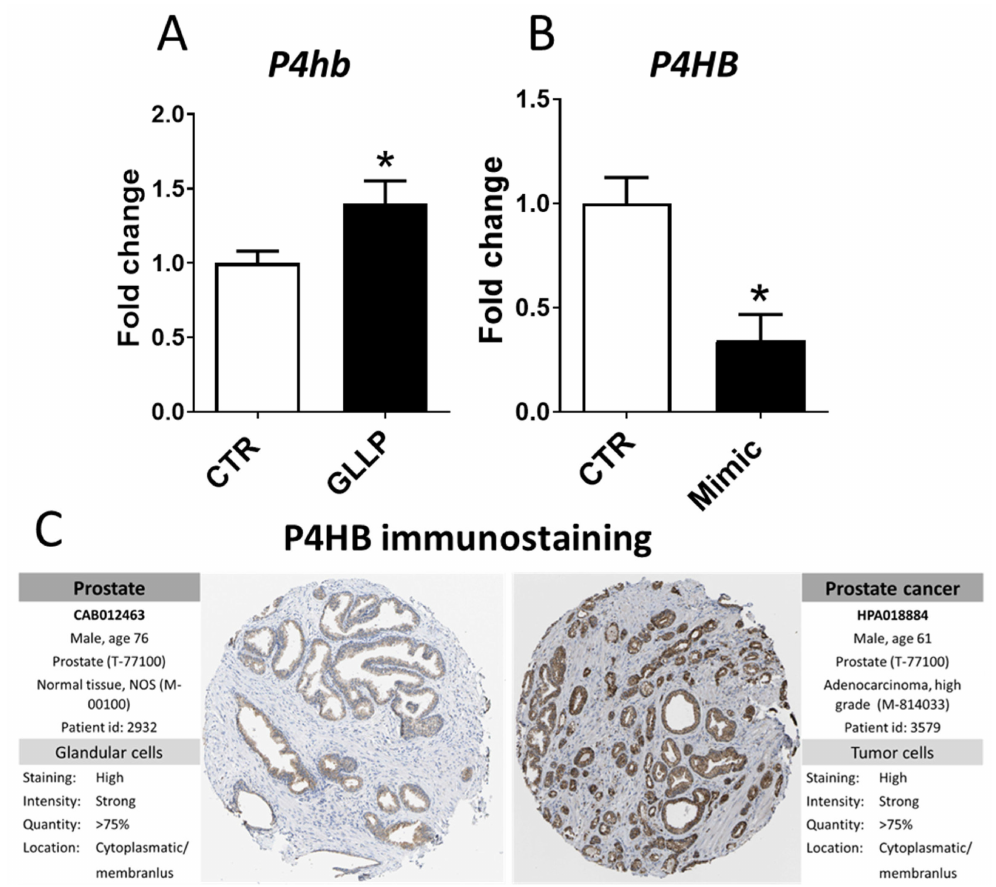
Figure 5. P4hb gene expression in the ventral prostate ( A ) of offspring rats from the CTR and GLLP groups at PND 540. ( B ) P4HB gene expression in the PNT-2 human prostate cells from the CTR and transfected with mimic miR-18a-5p groups. ( C ) P4HB immunostaining in normal and PRAD tissues obtained from The Human Protein Atlas database (https://proteinatlas.org/ (accessed on 4 May 2021)). Data are expressed as mean ± SD. * means a statistical difference between experimental groups with p < 0.05. CTR: Control group; GLLP: Gestational and Lactational Low Protein diet; VP: ventral prostate; PRAD: prostate adenocarcinoma.